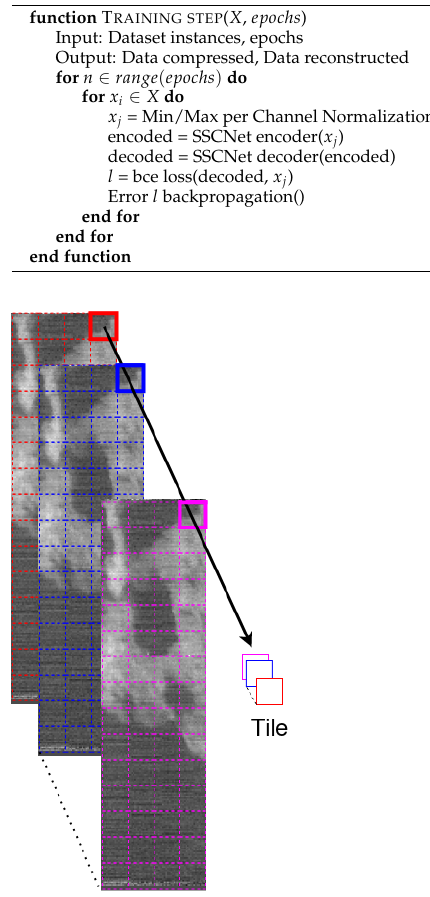
Figure 2. Subdivision strategy of multi/hypercube